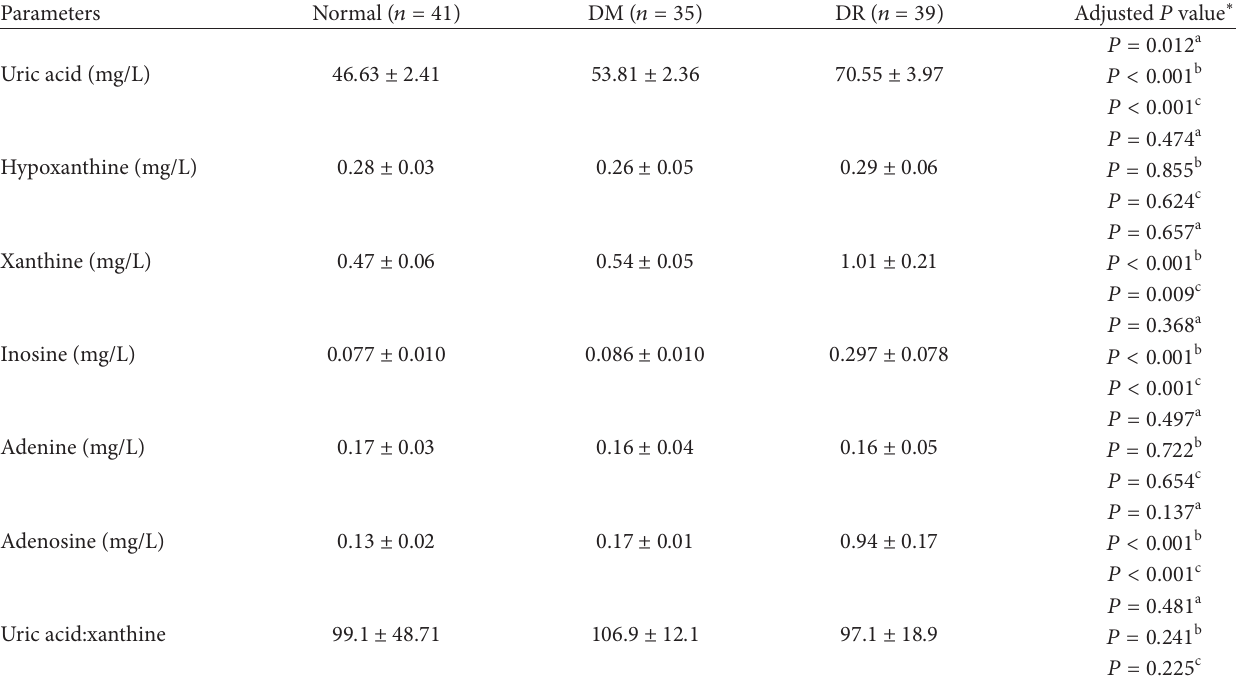
Table 2: Crude concentrations and adjusted 𝑃 value for six purine metabolites and ratio of uric acid to xanthine in diabetic patients with retinopathy (DR) and without retinopathy (DM) and healthy subjects